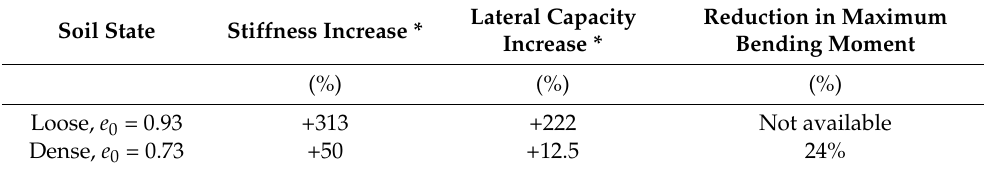
Table 1. Main outcomes of the centrifuge tests by Lalicata et al. [11]. Lateral Capacity Reduction in Maximum Soil State Stiffness Increase * Increase * Bending Moment (%) (%) (%) Loose, e 0 = 0.93 +313 +222 Not available Dense, e 0 = 0.73 +50 +12.5